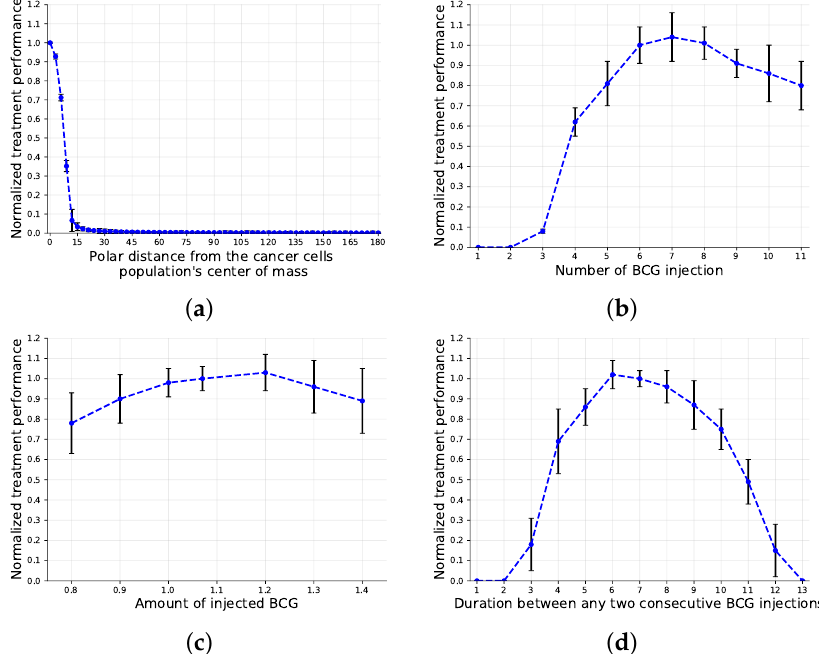
Figure 5. Sensitivity analysis of the four controlled parameters of the treatment protocol. The classical treatment protocol is based on the one proposed by [43] and provided in Table 1. The results are normalized to the classical treatment protocol and are shown as the mean ± standard deviation for n = 1000 repetitions. ( a ) BCG injection location ( Γ ); ( b ) number of BCG injections ( k ); ( c ) number of BCG cells injected ( b ); ( d ) duration between any two consecutive BCG injections ( τ